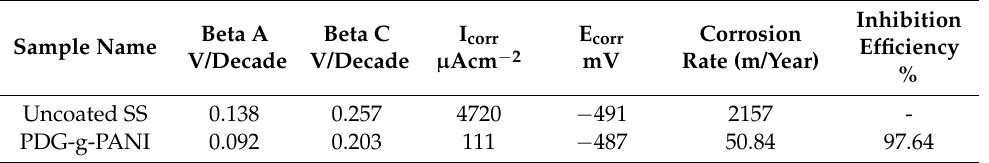
Table 6. Comparison of essential corrosion kinetic parameters of uncoated SS and PDG-g-PANI- coated SS in 1 M H 2 SO 4